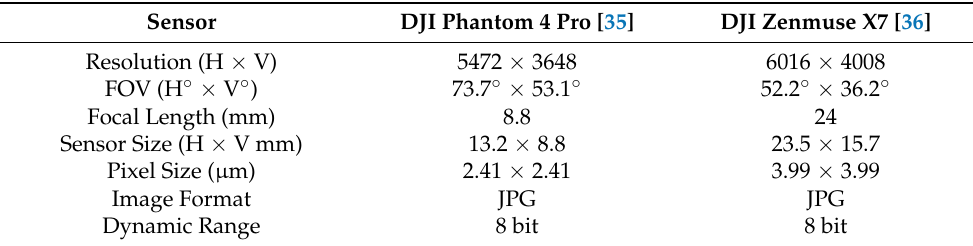
Table 2. Unmanned aerial vehicle (UAV) sensor parameters.